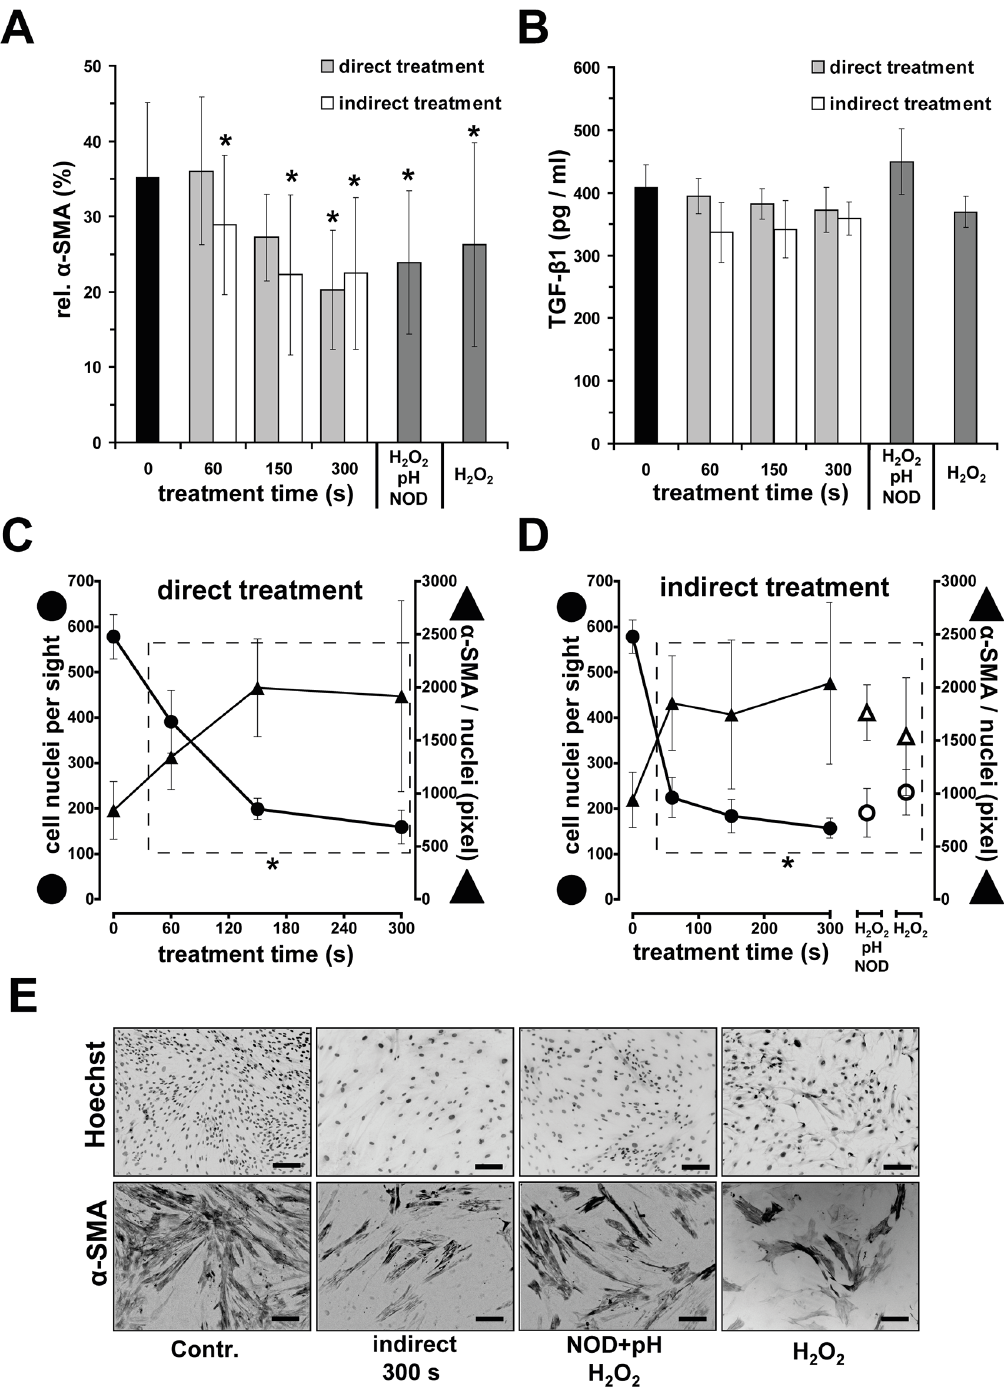
Fig 5. DBD treatment interferes with fibroblast/myofibroblast differentiation. A Quantification of alpha-smooth muscle actin of fibroblasts ( α -SMA) 12 days after direct/indirect DBD treatment. B TGF- β 1 concentrations in the supernatants seven days after treatment. C and D show number of Hoechst 33342 stained cell nuclei and α -SMA positive-stained area normalized to number of nuclei in 1.4 mm² cell culture plate 12 days after DBD treatment. E Representative microphotographs of Hoechst 33342-/ α -SMA-stained fibroblasts.In control experiments, fibroblasts were exposed (5 min) to acidified PBS (pH 6.7) containing concentrations of nitrite/nitrate ( NOD ; 300 μ M/1.0 mM) and hydrogen peroxide ( H2O2 ; 200 μ M), which are equivalent to concentrations obtained after a 300 s DBD treatment. Additionally, fibroblasts were exposed to PBS (pH 7.2) containing only H 2 O 2 (200 μ M). Given are the mean ± sd values (n = 5), * P < 0.05 as compared with the control